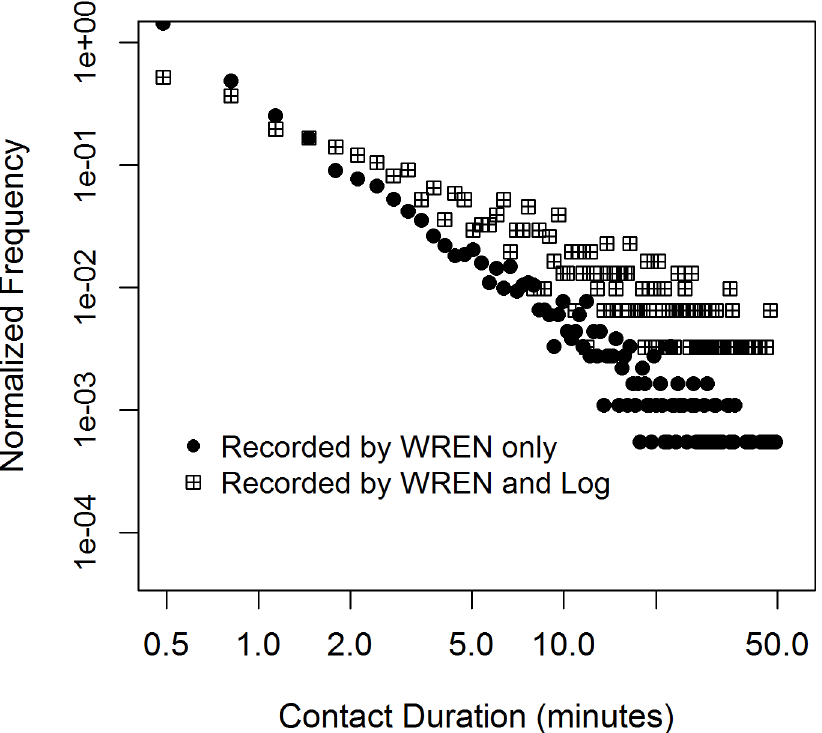
Fig 4. Normalized frequency of contact pairs by contact duration (in minutes) on a log-log scale for contacts captured by WREN only and contacts captured by both WREN and Log.